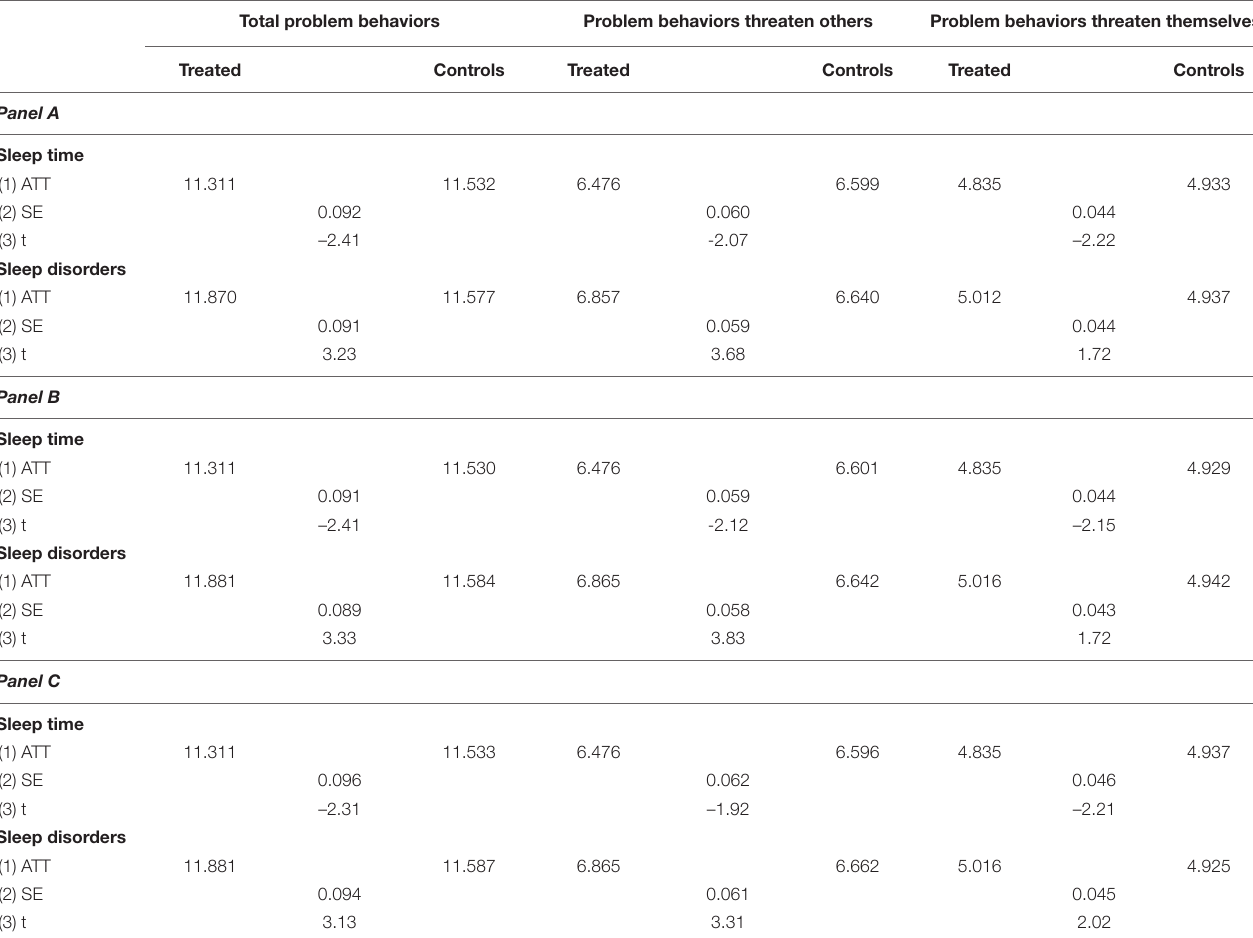
TABLE A1 | Main results of the propensity score matching